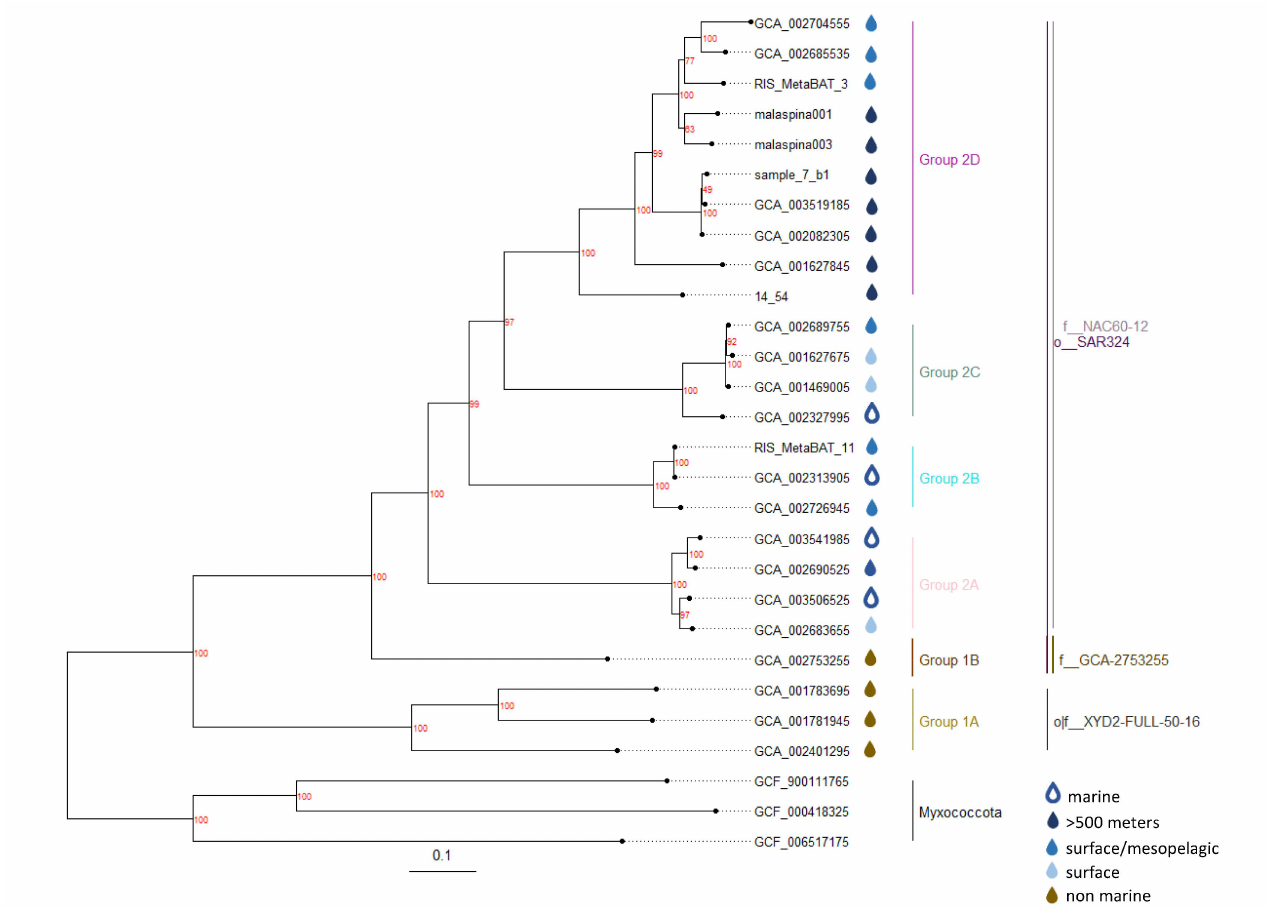
Figure 2. Phylogenetic maximum likelihood tree with de-replicated SAR324 genomes as well as genomes belonging to the phylum Myxococcota as an outgroup. Additionally, genomes are annotated with their origin based on the information available in public databases and their phylogeny based on the GTDB. More information regarding the sample location can be found in Supplementary Table S1. The tree is based on 120 bacterial marker genes and calculated with IQtree. We assigned names and colors to the different SAR24 clades based on their phylogeny and environment. The x -axis shows the phylogenetic distance